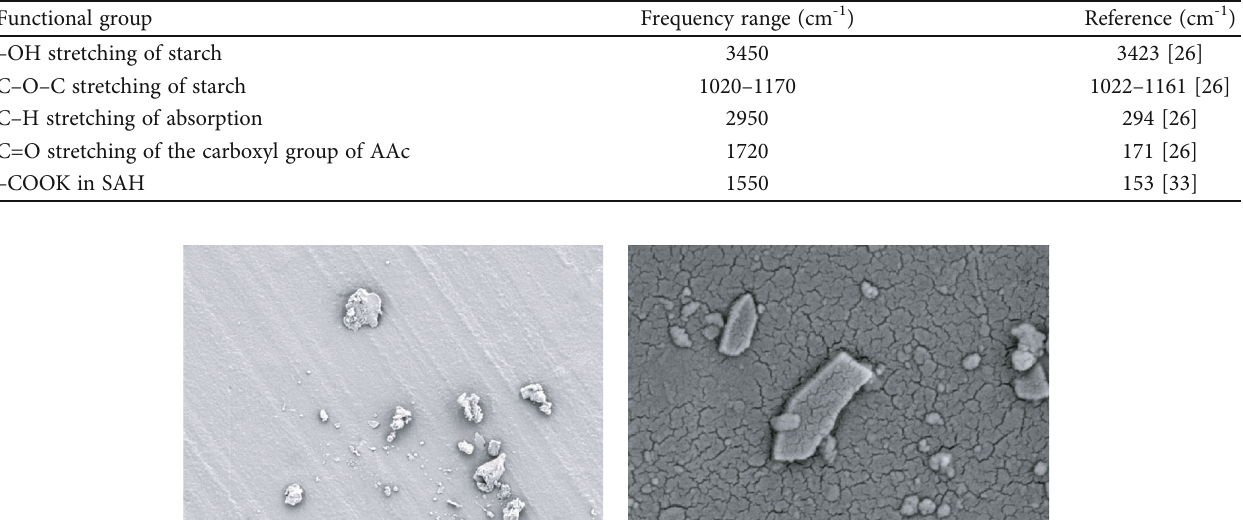
Table 1: Characteristic bands of di ff erent functional groups in hydrogels.